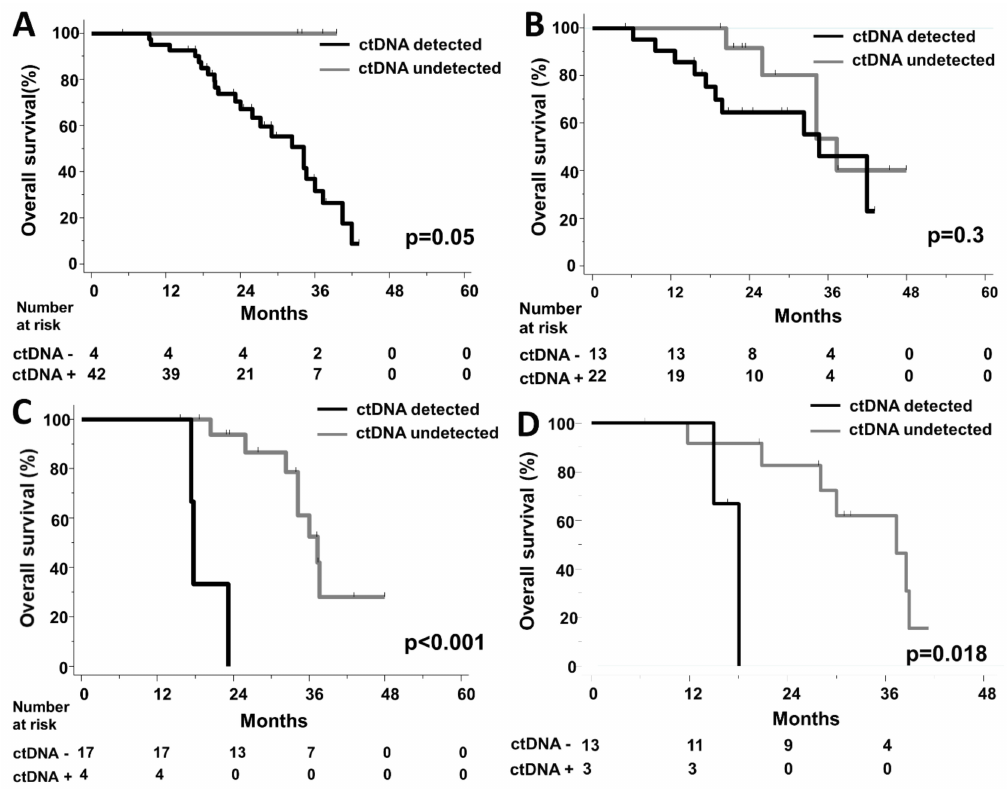
Figure 5. Kaplan–Meier curves for Overall Survival according to ctDNA detection ( A ) at baseline, ( B ) at 4 weeks, ( C ) before liver surgery ( D ) Kaplan–Meier curve for post-operative Overall Survival according to ctDNA detection before liver